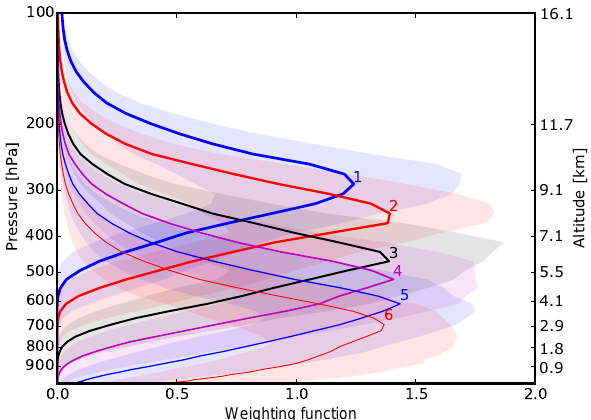
Figure 1. The weighting functions for the SAPHIR channels cal- culated using a subset of EUMETSAT profiles. The selected subset includes 5000 profiles, so that the shaded areas show the range for 25th and 75th percentiles of all profiles. The solid lines show the 50th percentile and the channels’ numbers are printed on the